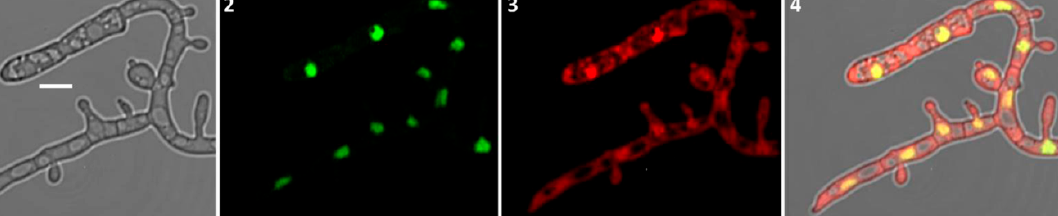
Figure 1. Recognition, expression and localization of Rad4A, Rad4B and Rad23 in B. bassiana . ( A ) Comparative domain architectures of Rad4 and Rad23 homologs in B. bassiana ( Bb ) and S. cerevisiae ( Sc ). Decimal value associated with the NLS motif of each protein is a maximal probability predicted for its nuclear localization. ( B ) Relative transcript (RT) levels of rad4A , rad4B and rad23 in a wild-type (WT) Bb strain over the days of incubation (relative to Day 2) on SDAY at the optimal regime of 25 °C and 12:12 (L:D). ( C ) LSCM images (scale: 5 μ m) for subcellular localization of Rad4A-GFP and Rad4B-GFP fusion proteins expressed in the WT hyphae at the optimal regime and stained with the nuclear dye DAPI (shown in red). Images 1–4 are bright, expressed, stained and merged views of the same microscopic field, respectively. ( D ) N/C-GFI ratios of Rad4A-GFP and Rad4B-GFP ( p , Student’s t test). ( E , F ) LSCM images (scale: 5 μ m) for nuclear localization of Rad4A-GFP and Rad4B-GFP (Image 2) co-expressed with Rad23-mCherry (Image 3) in the WT strain, respectively. Error bars: standard deviations (SDs) from three cDNA samples analyzed ( B ) or 15 hyphal cells ( D ).